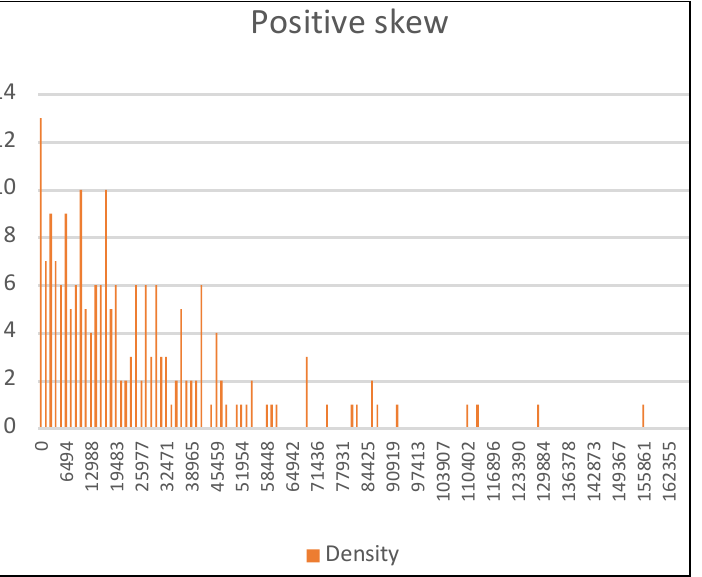
Figure 2. We represent a distribution generated by ECA for Distribution = 100r of a population of 5,000,000 organisms. The X -axis represents the density of each cell and the Y -axis is the number of cells. The skewness coefficient is positive (2.08) and the standard deviation is 24,738.08. It is a negative binomial distribution.